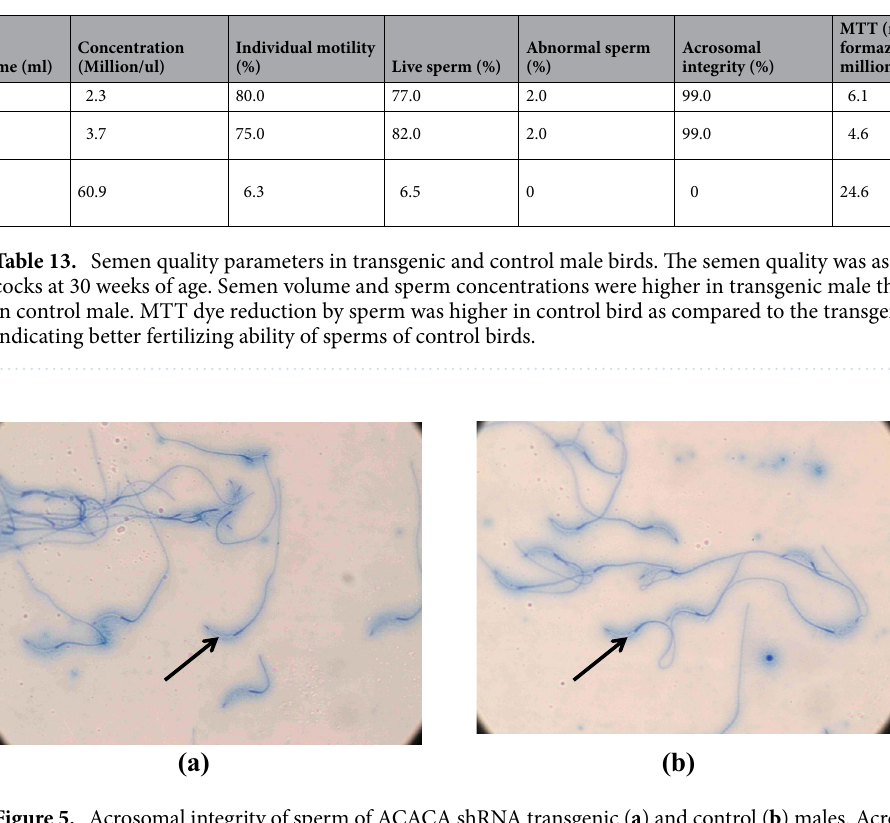
Figure 5. Acrosomal integrity of sperm of ACACA shRNA transgenic ( a ) and control ( b ) males. Acrosomal integrity expressed in terms of sperms are viewed under microscope with 20×